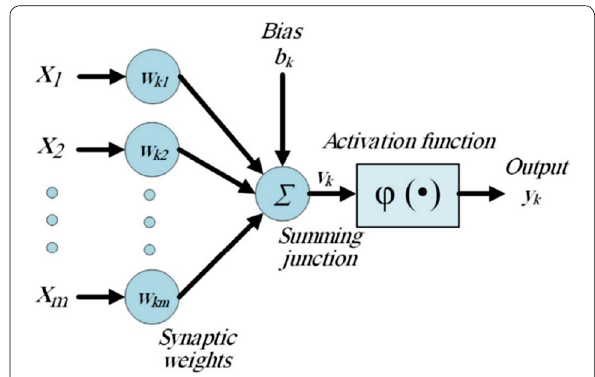
Fig. 4 Neural Network architecture Source: adapted from [16]